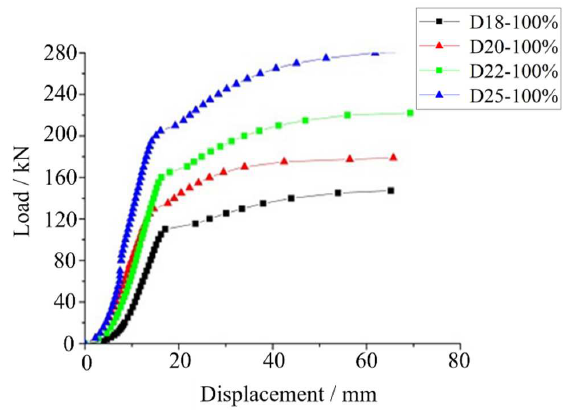
Figure 7. Load-displacement curves for fully compact GSS connectors.